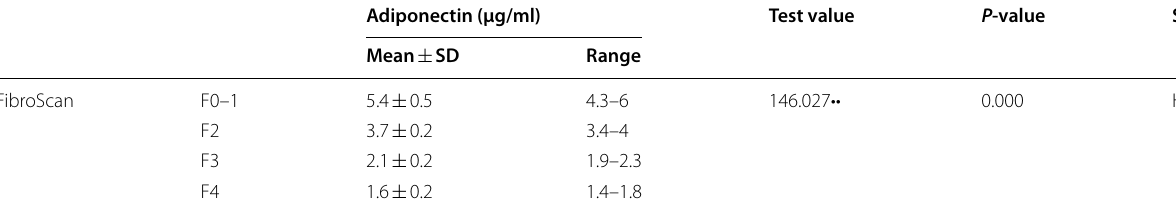
P -value > 0.05, non-significant; P -value < 0.05, significant; P -value < 0.01, highly